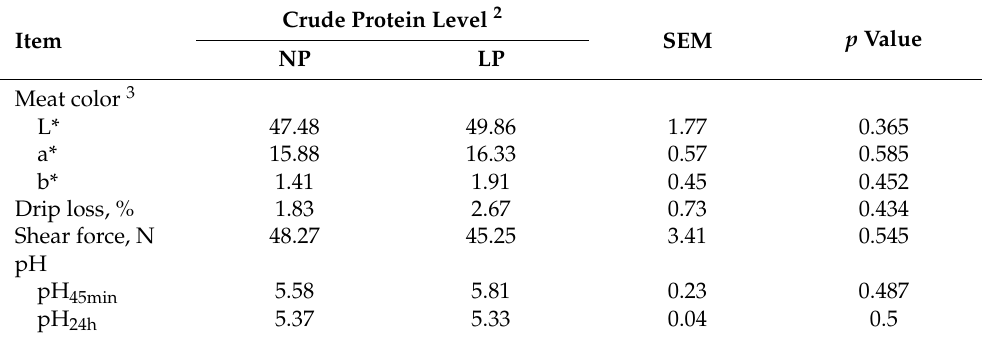
Table 4. Effects of dietary crude protein level on the meat quality of finishing pigs 1 .